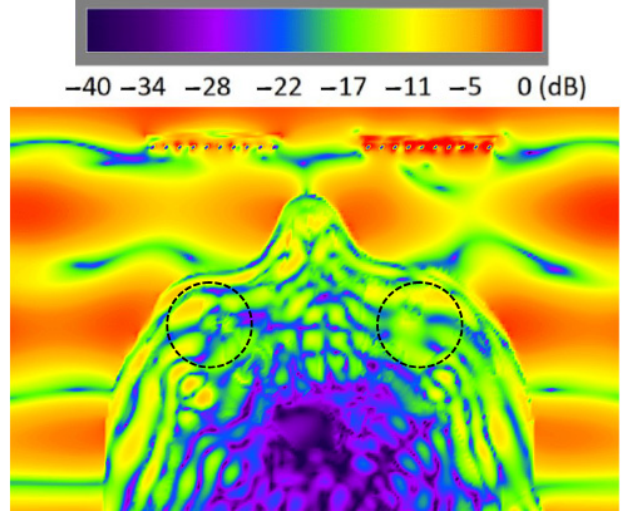
Figure 15. Power density distribution without shield (horizontal polarization); reference value 0 dB = 40 W/m 2 . The regions in the circle are the areas of the eye.